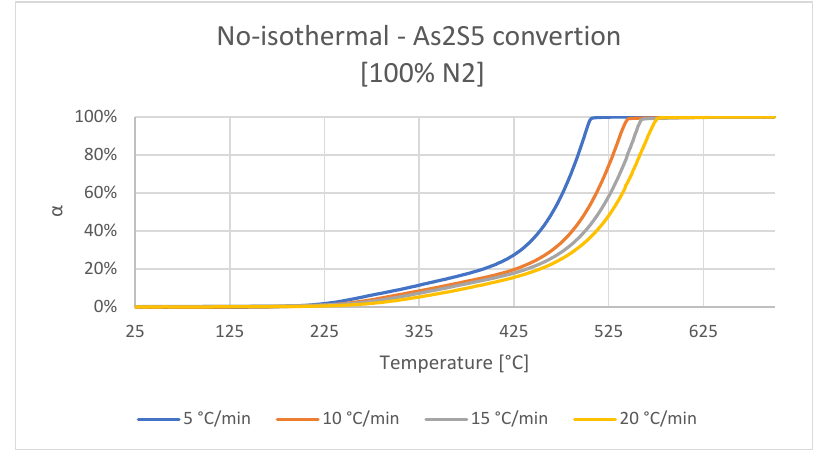
Figure 2. Fraction converted from As 2 S 5 to an inert atmosphere [own elaboration].